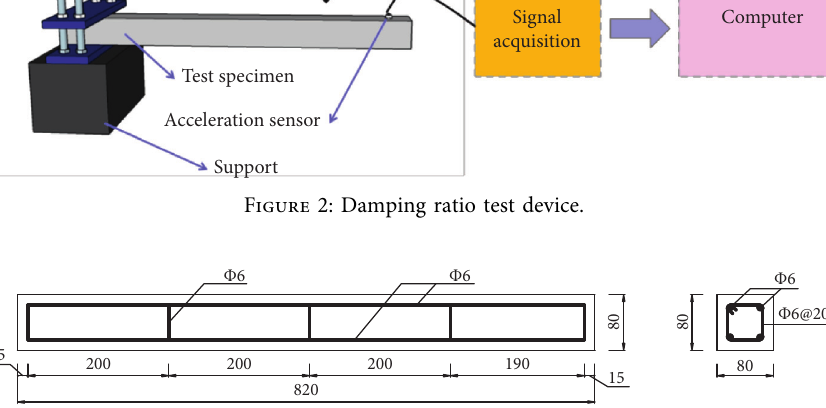
Figure 3: Schematic diagram of reinforcement distribution inside the cantilever